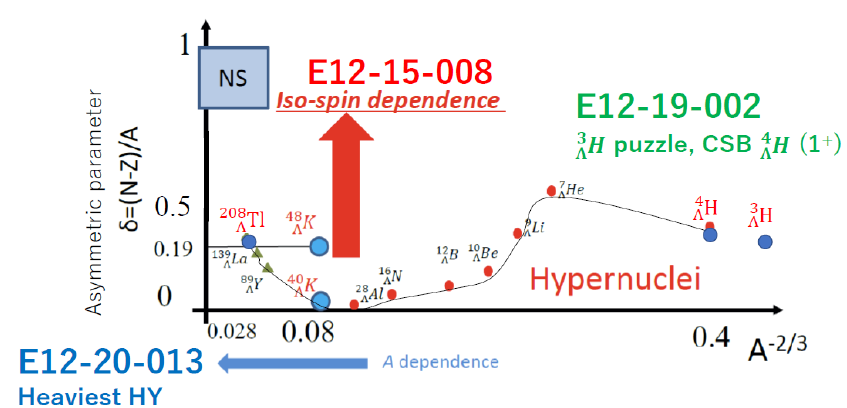
Figure 3. Mass number ( A − 2 / 3 ) and asymmetric of parameter ( δ = ( N − Z ) / A ) of Λ hypernuclei which are able to be produced from the stable targets by the ( e , e ′ K + )